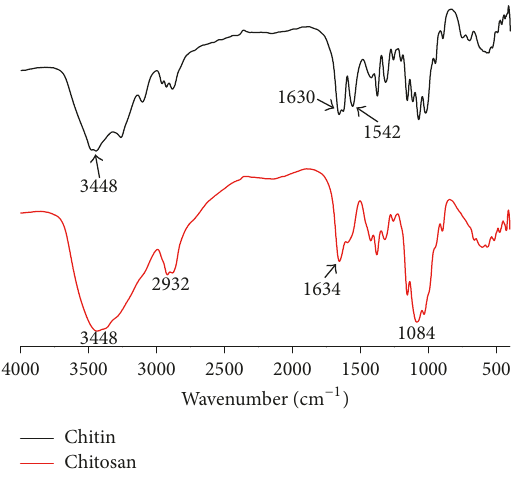
Figure 3: FTIR spectra of chitin and